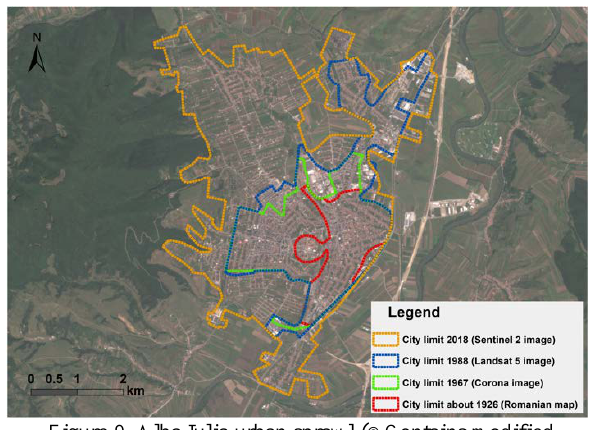
Figure 9. Alba Iulia urban sprawl (©Contains modified Copernicus Sentinel-2 data